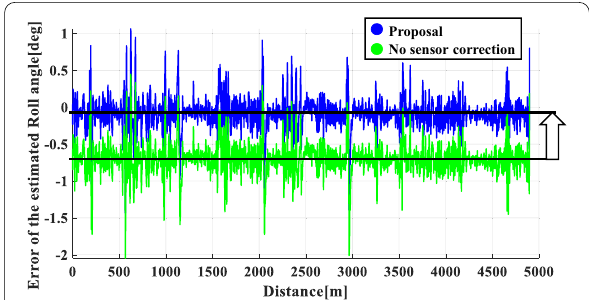
Fig. 12 Error of estimated roll angle (Urban street)